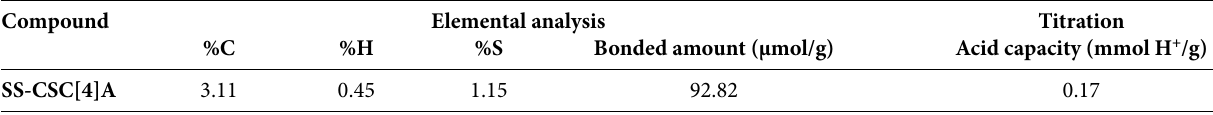
Table 1. The results of elemental analysis and titration of SS-CSC[4]A. Compound Elemental